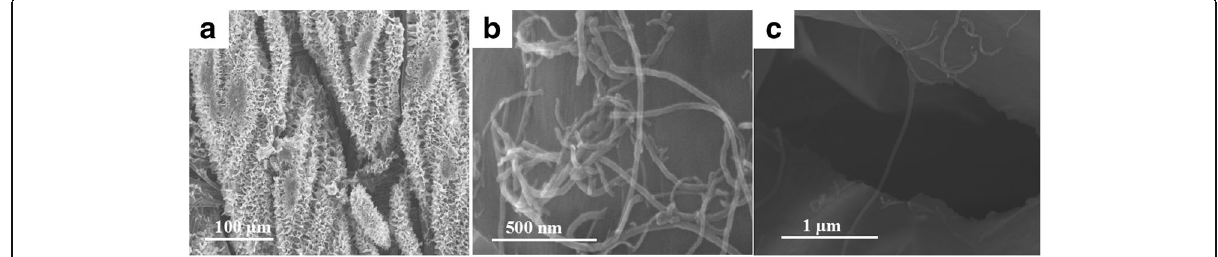
Fig. 5 Microstructure of CNT-coated V 6 O 13 electrode. a Low-resolution SEM image of the electrode. b , c High-resolution SEM image of the electrode showing CNT covering on the nanosheet and bridging between the